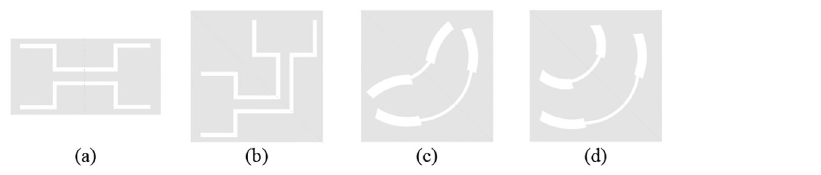
Fig 3. The evolution process of CPW. (a) traditional SIR-based CPW. (b) symmetry to 45˚ axis. (c) arc type. (d) uniform impedance change.